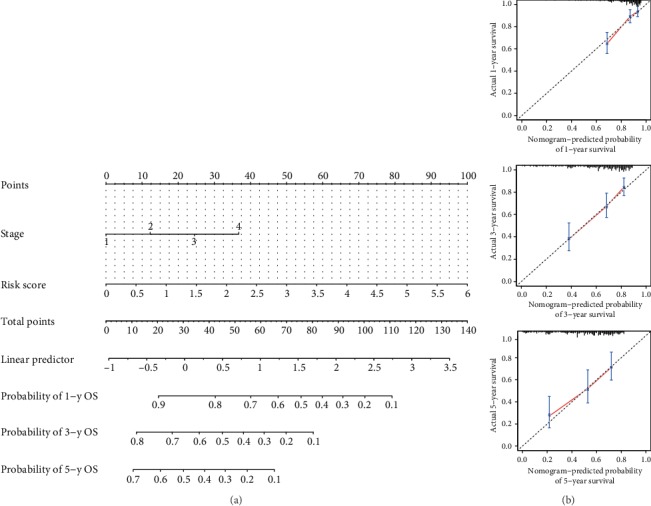
Construction of a nomogram based on the three-gene signature for overall survival prediction. (a) The nomogram combining the risk score and TNM stage. (b) The calibration plots showed that the predicted 1-, 3- and 5-year survival probabilities agreed well with the actual observations.